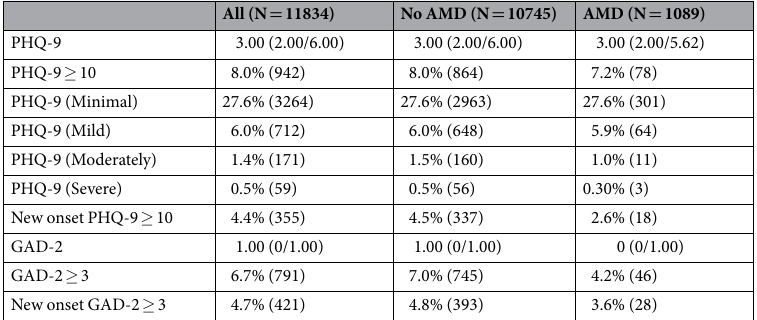
Table 2. Prevalence and new onset of depression and generalized anxiety in participants with and without AMD in the Gutenberg Health Study. Abbreviations: AMD (age-related macular degeneration), PHQ-9 (Patient Health Questionnaire), GAD-2 (Generalized Anxiety Disorder Scale). PHQ-9 ≥ 10 defined as caseness for depression, GAD-2 ≥ 3 defined as caseness for generalized